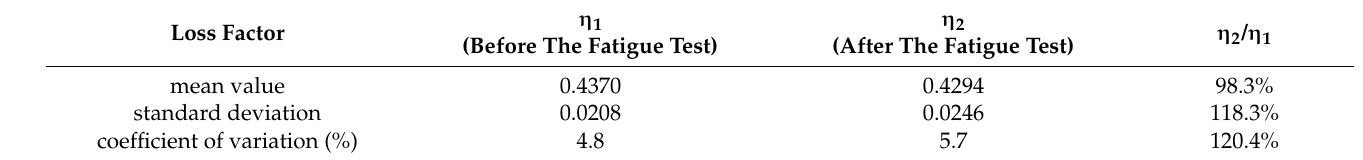
Table 8. Experimental results of the loss factor η for Mat